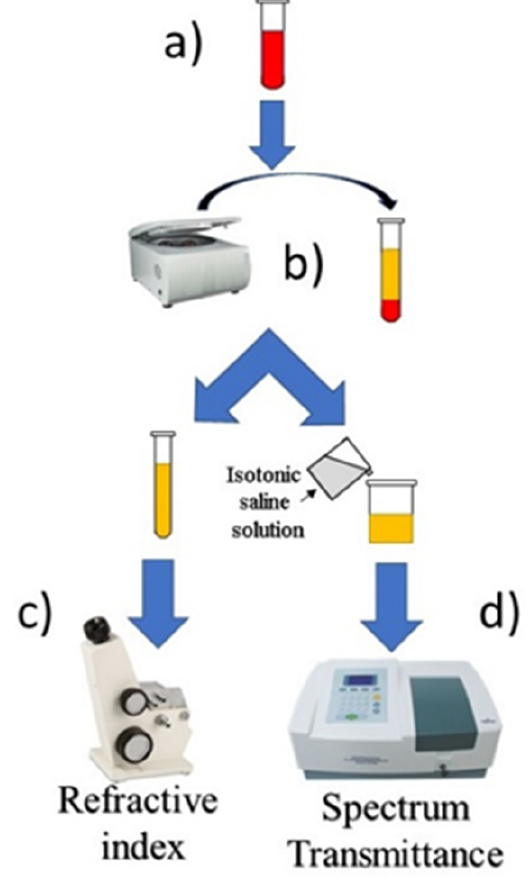
Figure 1. Methodology for obtaining the plasma refractive index and transmittance spectrum. Whole blood sample for analysis ( a ). Centrifugation to separate the blood sample into its components ( b ). The samples are divided into two volumes: one sample is measured using the Abbe refractometer (CJHZYG, model 2WAJ, Shenzhen, China), and its RI is measured ( c ); the other sample is diluted with a 0.9% NaCl solution, and its absorbance and transmittance spectrum is measured using a spectrophotometer (XZBELEC, model V1710, Shenzhen, China) ( d ).